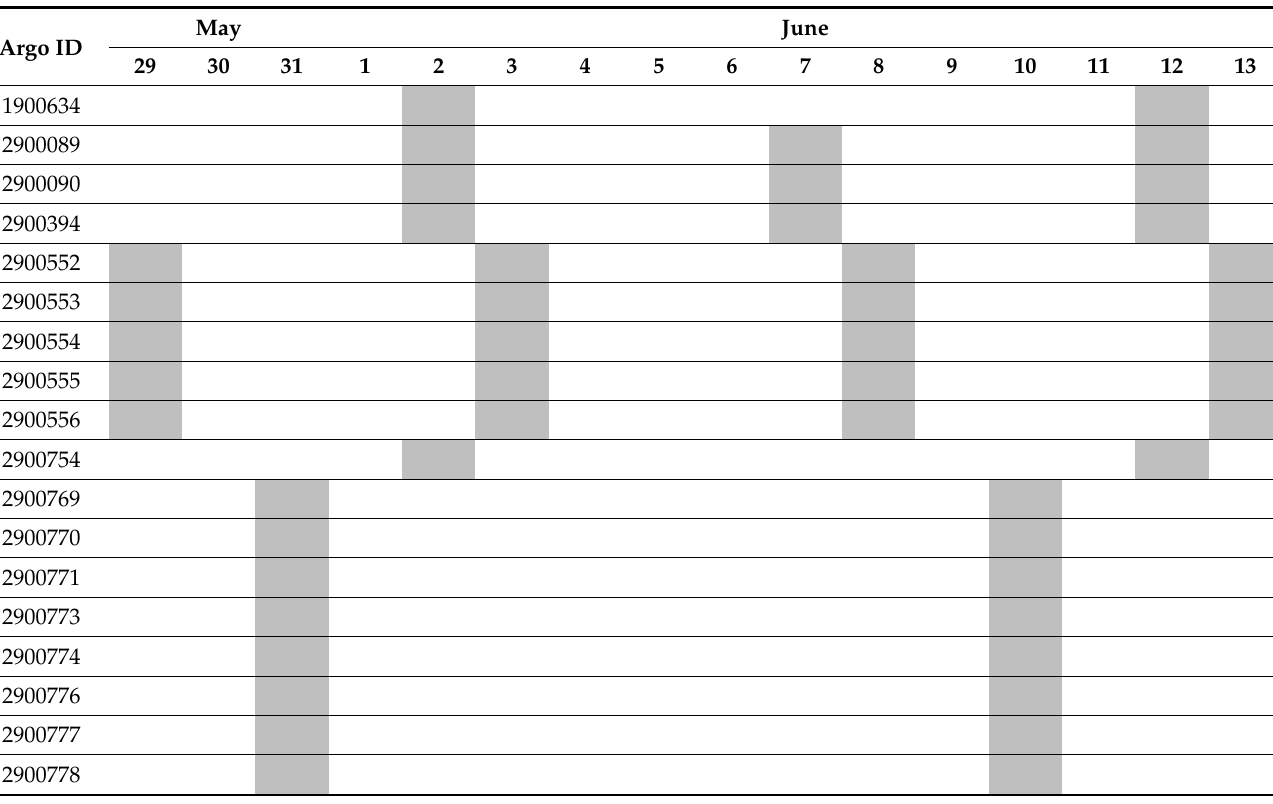
Table A1. A: Timetable of Argo measurements between 29 May and 13 June 2007 within the affected area (the shading means that Argo was active on that specific day and measured